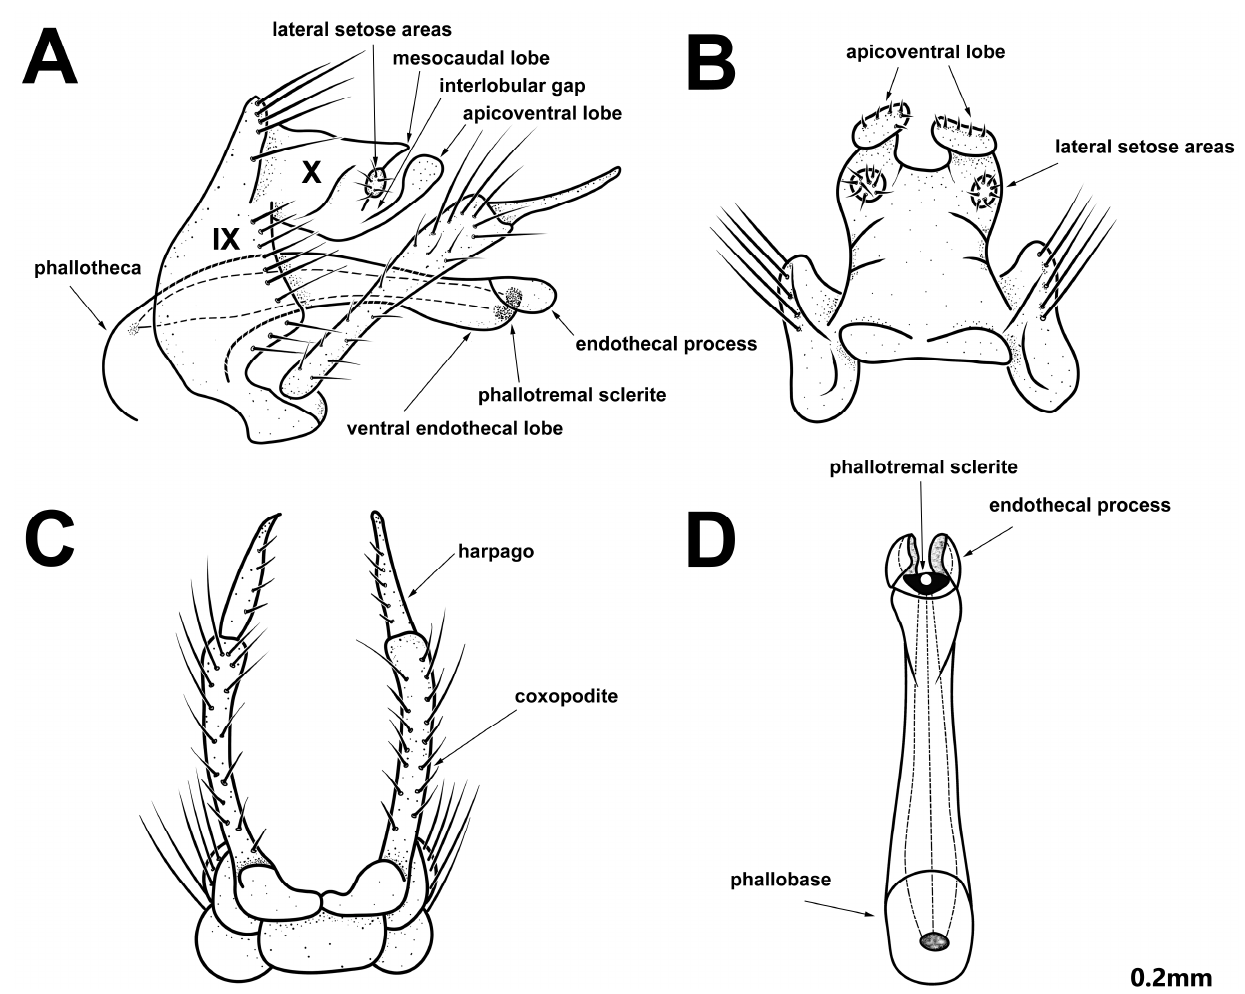
Figure 2. Male genitalia of Cheumatopsyche latisecta sp. nov. ( A ), genitalia, left lateral view; ( B ), genitalia, dorsal view; ( C ), genitalia, ventral view; ( D ), phallus ventral view. Abbreviations: IX = segment IX; X = segment X. Scale bar: 0.2 mm.